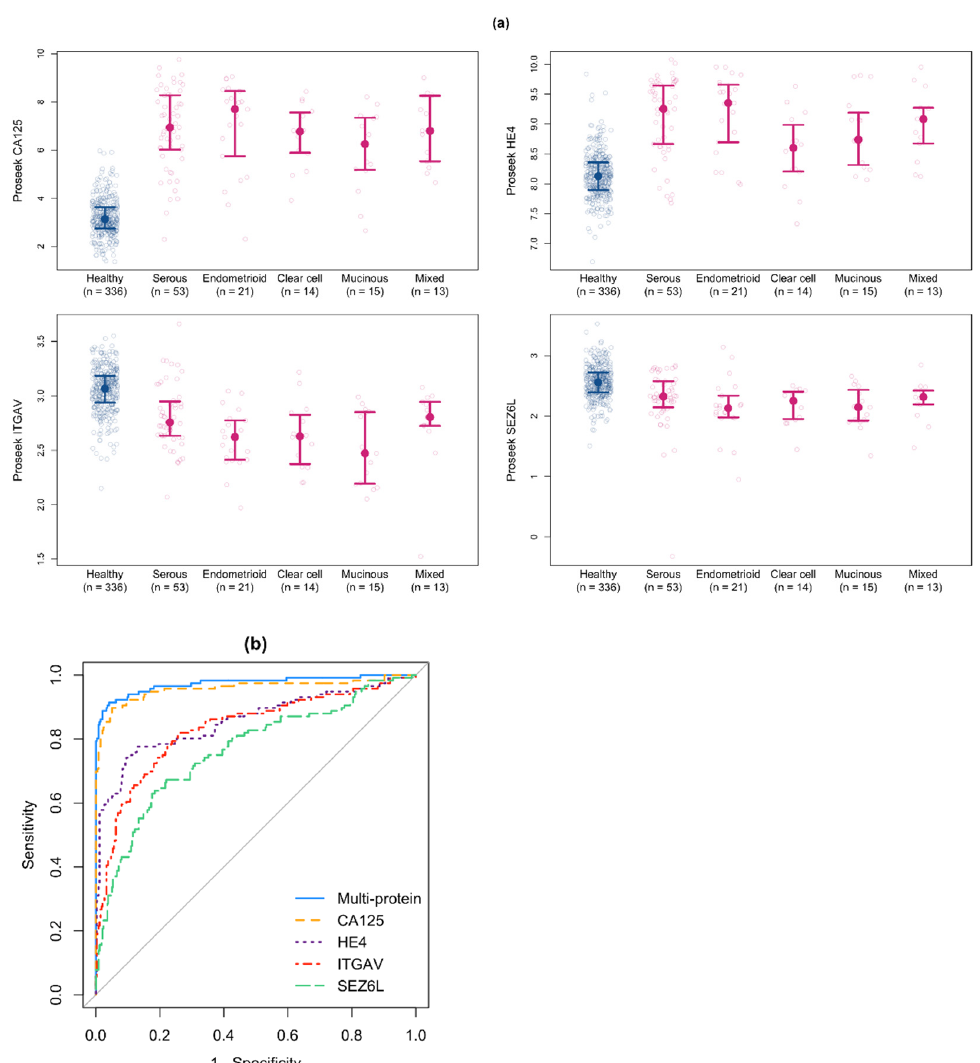
Figure 3. Development of a multiprotein classifier from samples in Cohort #1. ( a ) Proseek Oncology II NPX values were plotted with the median and 25th and 75th percentiles for the healthy patients (blue) and the 5 subtypes of early stage ovarian cancer (pink) for the four proteins included in the multiprotein classifier. ( b ) ROC curves for the multiprotein classifier and each of the four individual proteins included in the multiprotein classifier.